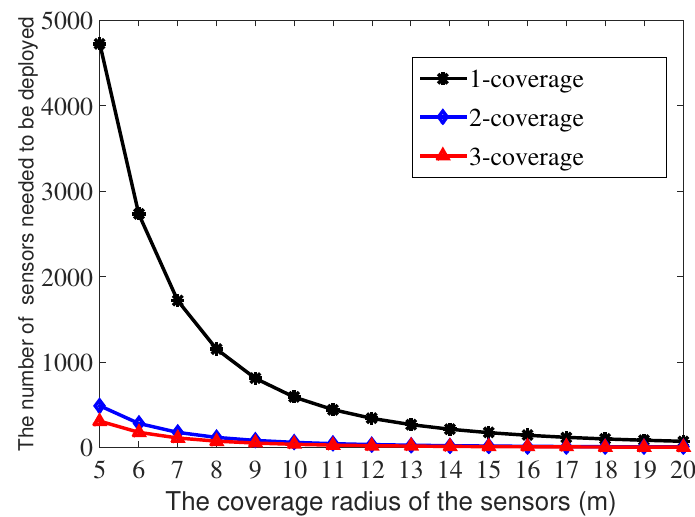
Figure 9. The correlation between r and the number of nodes needed to achieve an 89% k -coverage rate.